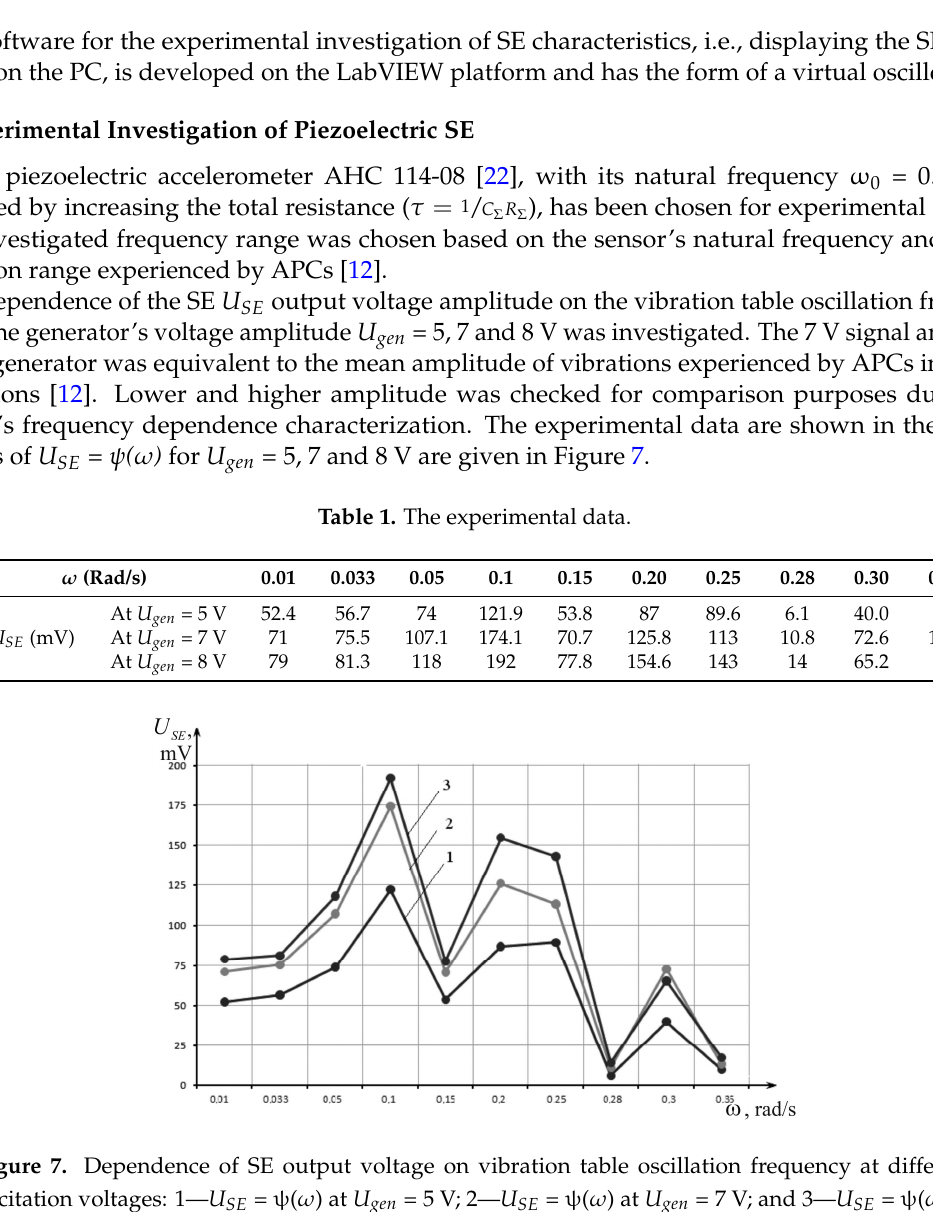
Figure 6. Investigated piezoelectric SE: ( a ) general view; ( b ) construction diagram: 1—PE; 2—insulators; 3—IM; 4—shielding; 5—base; 6—screw; 7—cable.